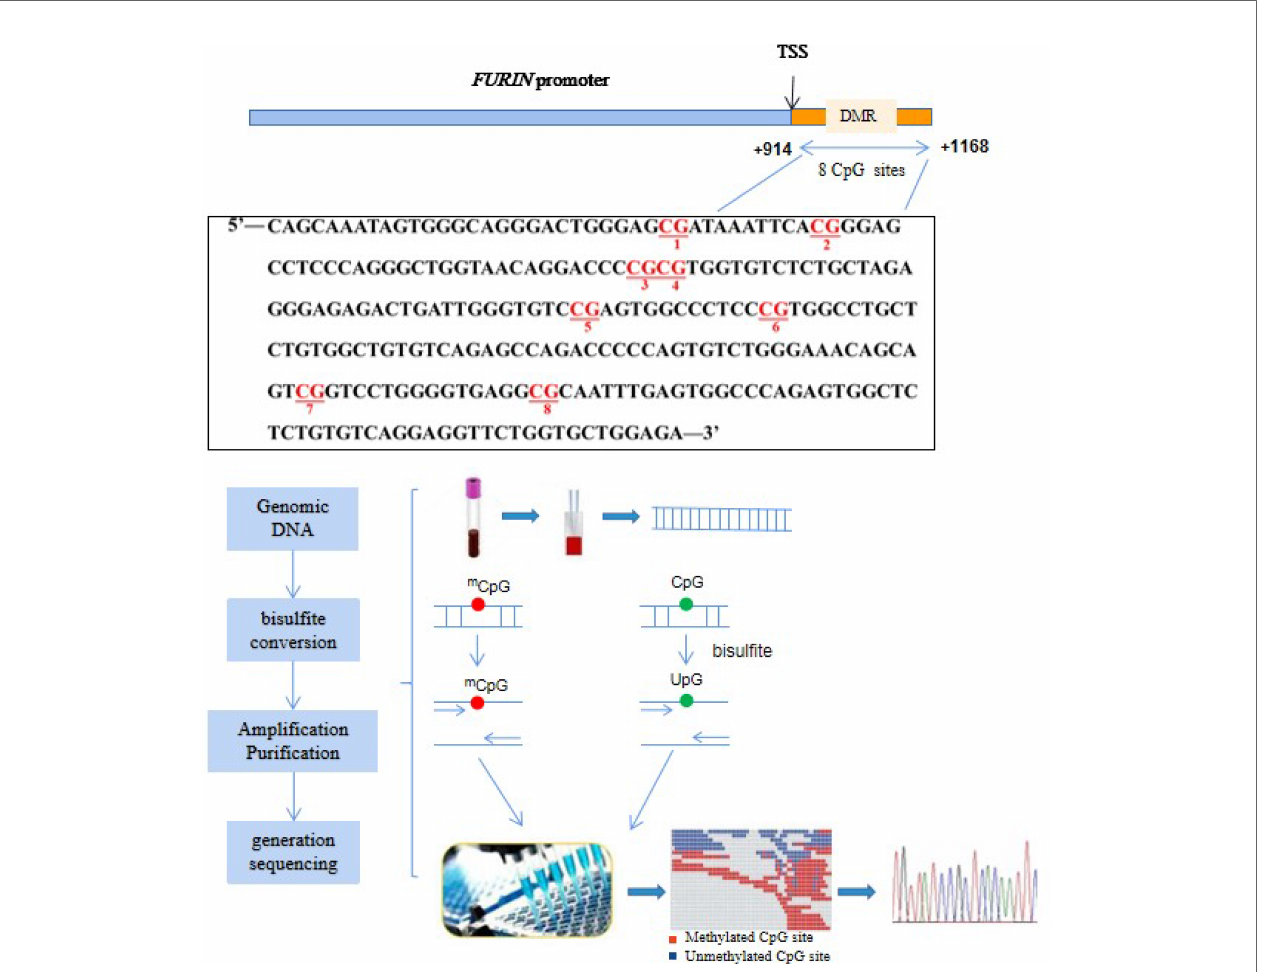
FIGURE 1 | Illustration of the measurements of FURIN promoter methylation. The red text represents the 8 CpG loci in the FURIN gene promoter that were assayed in this study (+914 to +1168 bp from TSS). TSS, transcriptional start